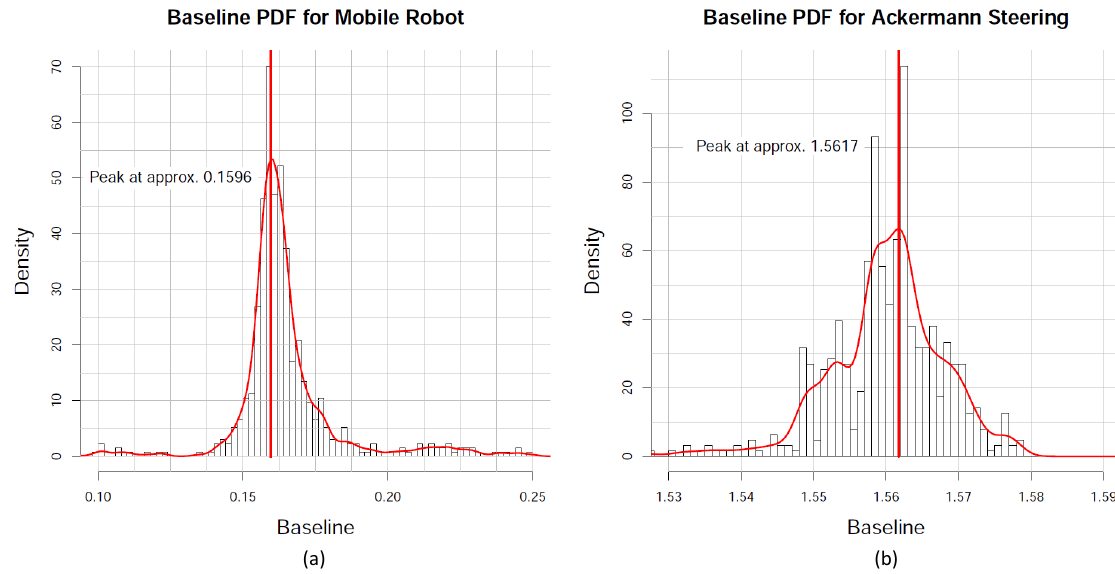
Figure 8. Baseline estimation for both kinematic models using kernel density estimation and maximum (red line). The used bin sizes are 0.002 m for mobile robot baseline ( a ) and 0.001 m for Ackermann steering ( b